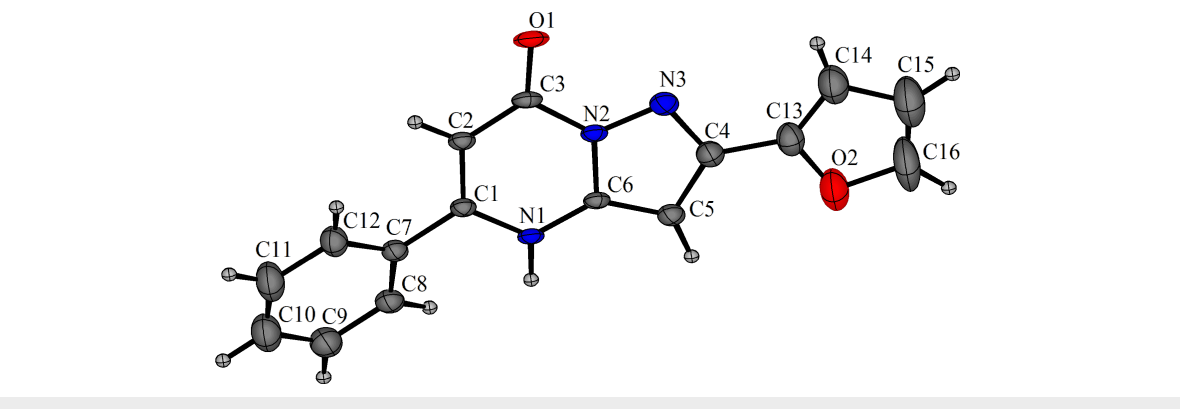
Figure 2: X-ray crystal structure of pyrazolo[1,5- a ]pyrimidinone 3m with ellipsoids at 50% probability.